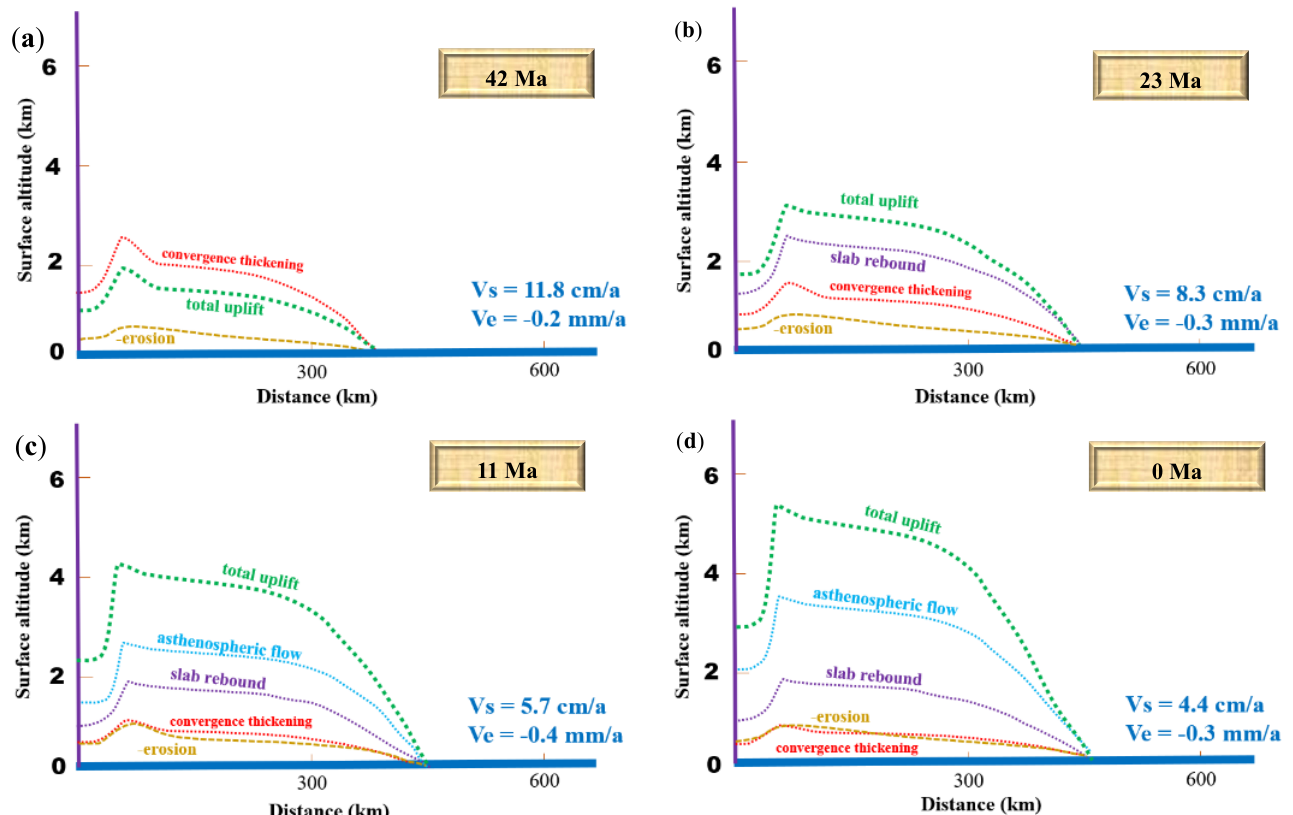
Figure 6. Model calculation of the surface height in the four periods along the profile AA’ in Fig. 3d. The curves indicate the net uplift effect for the Himalayas due to different tectonic processes, including convergence-induced thickening, slab rebound, asthenospheric flow, and surface erosion, at the end of the four evolutionary stages of the Himalayas. ( a ) 60 − 42 Ma. ( b ) 42 − 23 Ma. ( c ) 23 − 11 Ma. ( d ) 11 − 0